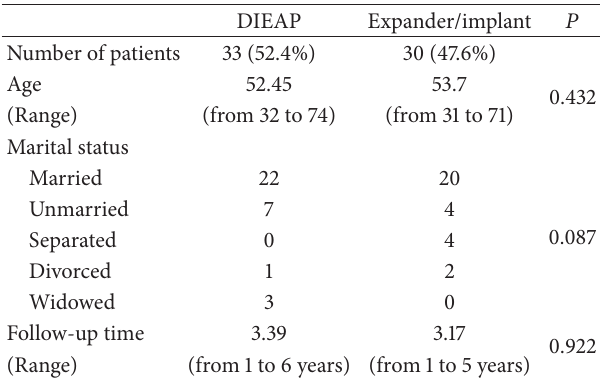
Table 1: Demographical data of the two groups, showing no statistically significant differences between